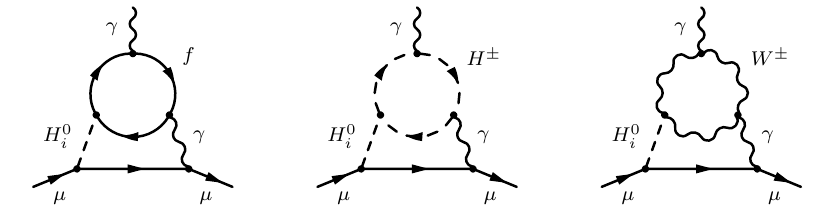
Figure 7 . Two Loop Barr-Zee diagrams contributing to the lepton dipole